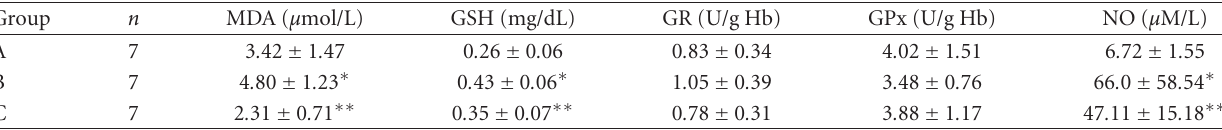
Table 2: Comparison of MDA, GSH, GR, GPx, and NO • derivate levels. Group n MDA ( μ mol/L) GSH (mg/dL) GR (U/g